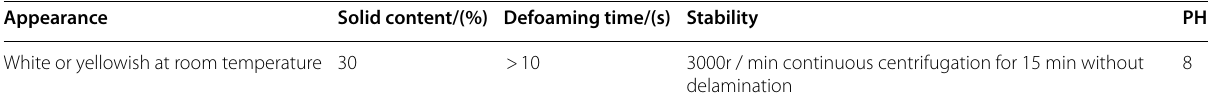
Table 5 Performance index of defoamer